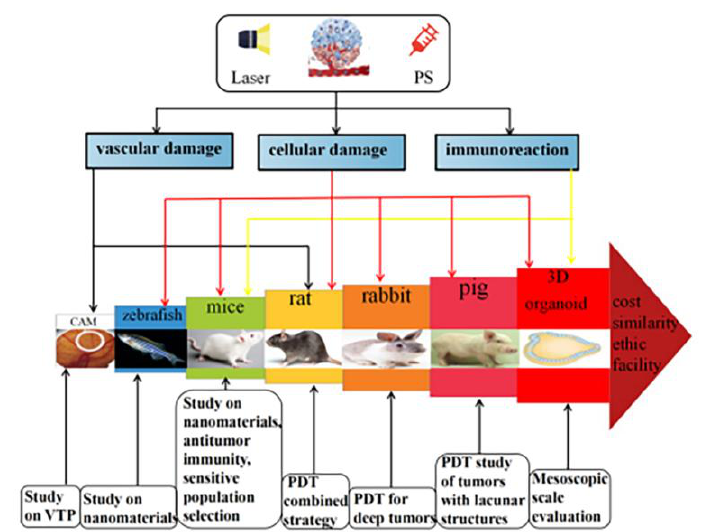
Figure 1. Selection of preclinical models commonly used in tumor treatment by PDT irradiation.